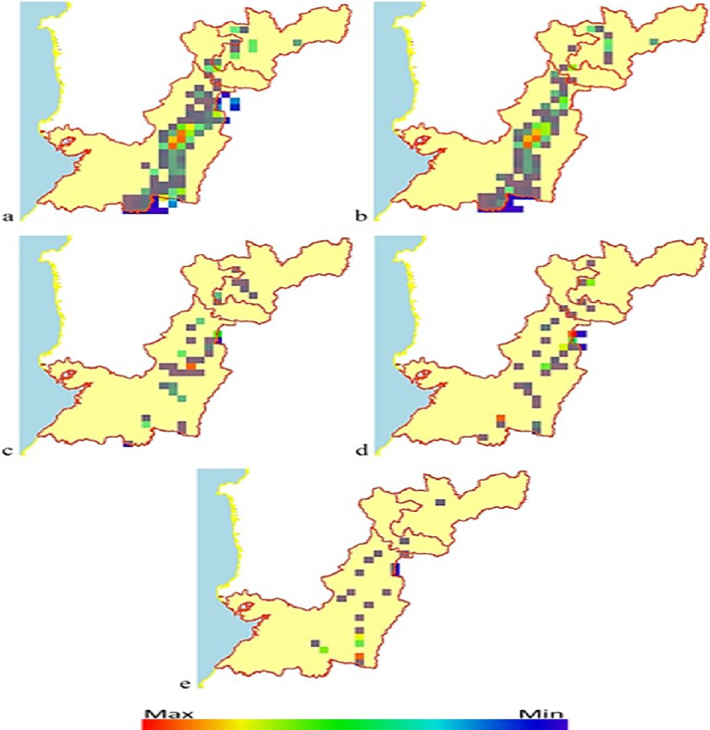
Fig 12. Distribution of Diatraea busckella under different climate change projections (BCC-CSM1-1) over 50 years in the departments of Caldas (top), Risaralda (middle) and Valle del Cauca (bottom) in southwestern Colombia. a) current condition, b) rcp26, c) rcp45, d) rcp60, e) rcp85. Color indicates maximum or minimum presence in a likely niche and under favorable